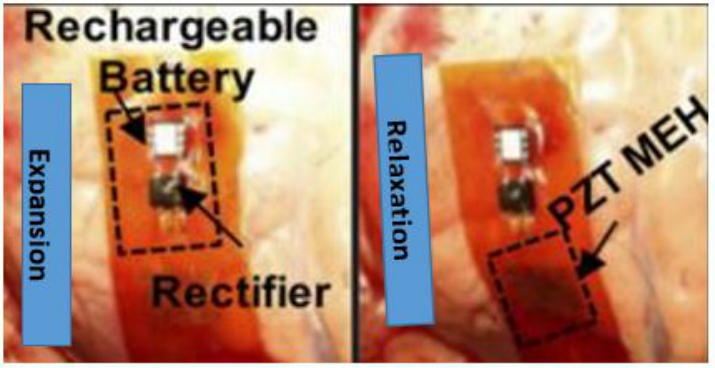
Figure 17. PEH for pacemaker. Expansion and relaxation of the pacemaker for the generation of voltage